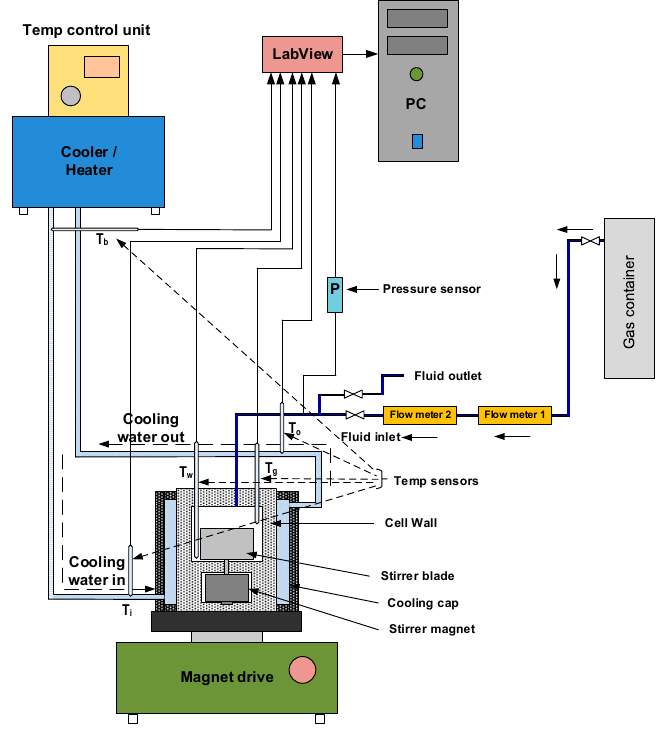
Figure 1. Experimental apparatus. Table 1. Details of autoclaves used in this work.